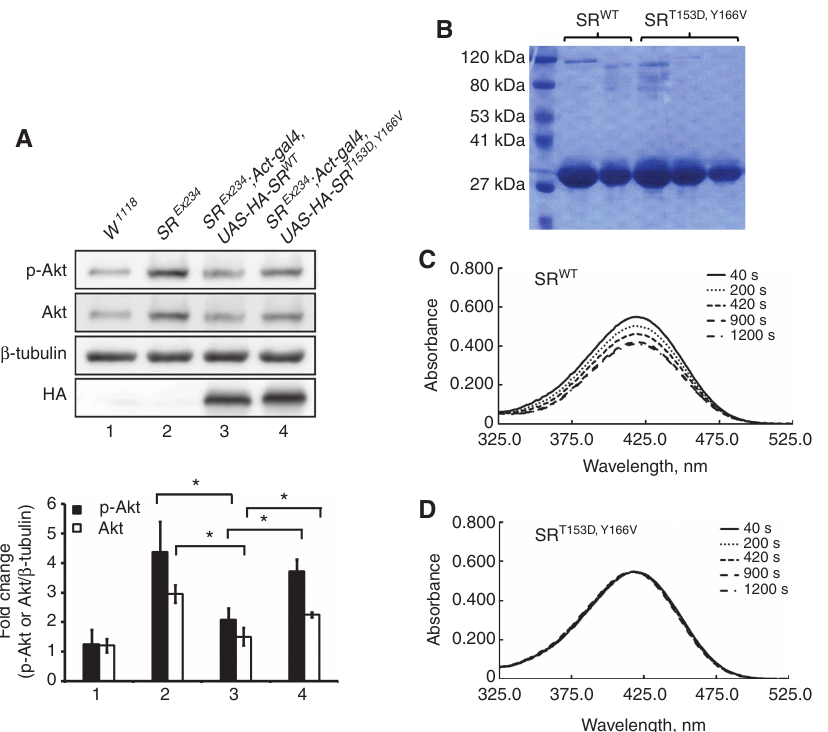
Figure 3: The Akt pathway is affected in the SR Ex234 mutant. (A) Western blot analysis of wild-type and mutant Drosophila cell lysate was performed using anti-p-Akt, anti-Akt, anti- β -tubulin, and anti-HA antibodies. The levels of both p-Akt and Akt were elevated in the SR Ex234 mutant (lanes 1 and 2). The increases in p-Akt and Akt were restored by the expression of SR WT (lane 3). Expression of catalytically inactive SR T153D/Y166V showed a small rescue effect compared to that of active SR (lanes 3 and 4). β -Tubulin was used as a loading control. HA was used to detect the expression of exogenous genes. The graph indicates the quantification of p-Akt and Akt levels. Error bars show the standard deviation (SD) of three independent experiments. Asterisks indicate significance by Student’s t-test (*p < 0.05). (B–D) Validation of the cata- lytic impairment of the SR T153D/Y166V mutant. (B) Sodium dodecyl sulfate-polyacrylamide gel electrophoresis (SDS-PAGE) of recombinant SR WT and SR T153D/Y166V . Proteins were separated on a 10% polyacrylamide gel in the presence of SDS and stained by Coomassie brilliant blue. (C) Spectra of reactions catalyzed by recombinant SR WT . Consumption of sepiapterin was monitored spectrophotometrically and recorded at the indicated time point. (D) Spectra of the reaction catalyzed by recombinant SR T153D/Y166V mutant. Consumption of sepiapterin was not